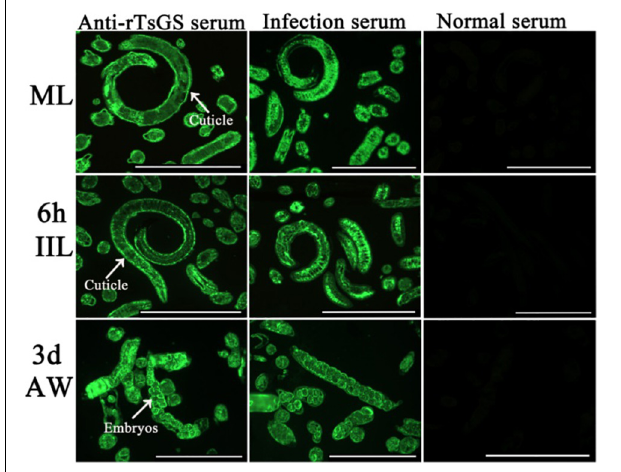
FIGURE 6 | Immunolocalization of TsGS in worm cross-sections of diverse Trichinella spiralis stages by IIFA with anti-rTsGS serum. Fluorescence staining was observed at the cuticle and around embryos of the nematode. The worms recognized by infection serum served as a positive control and normal serum as the negative control. Scale bars = 100 µ